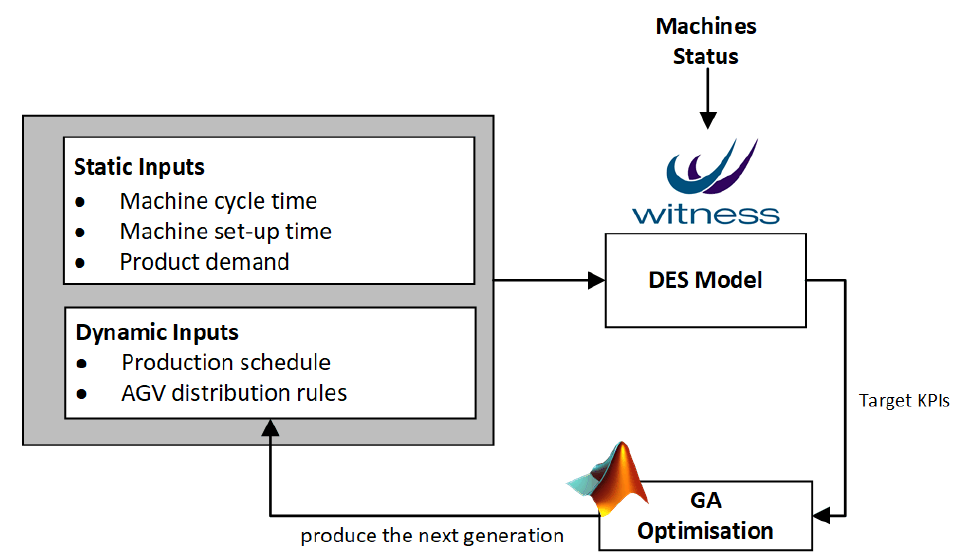
Figure 5. The data-flow between the optimisation module and the DES